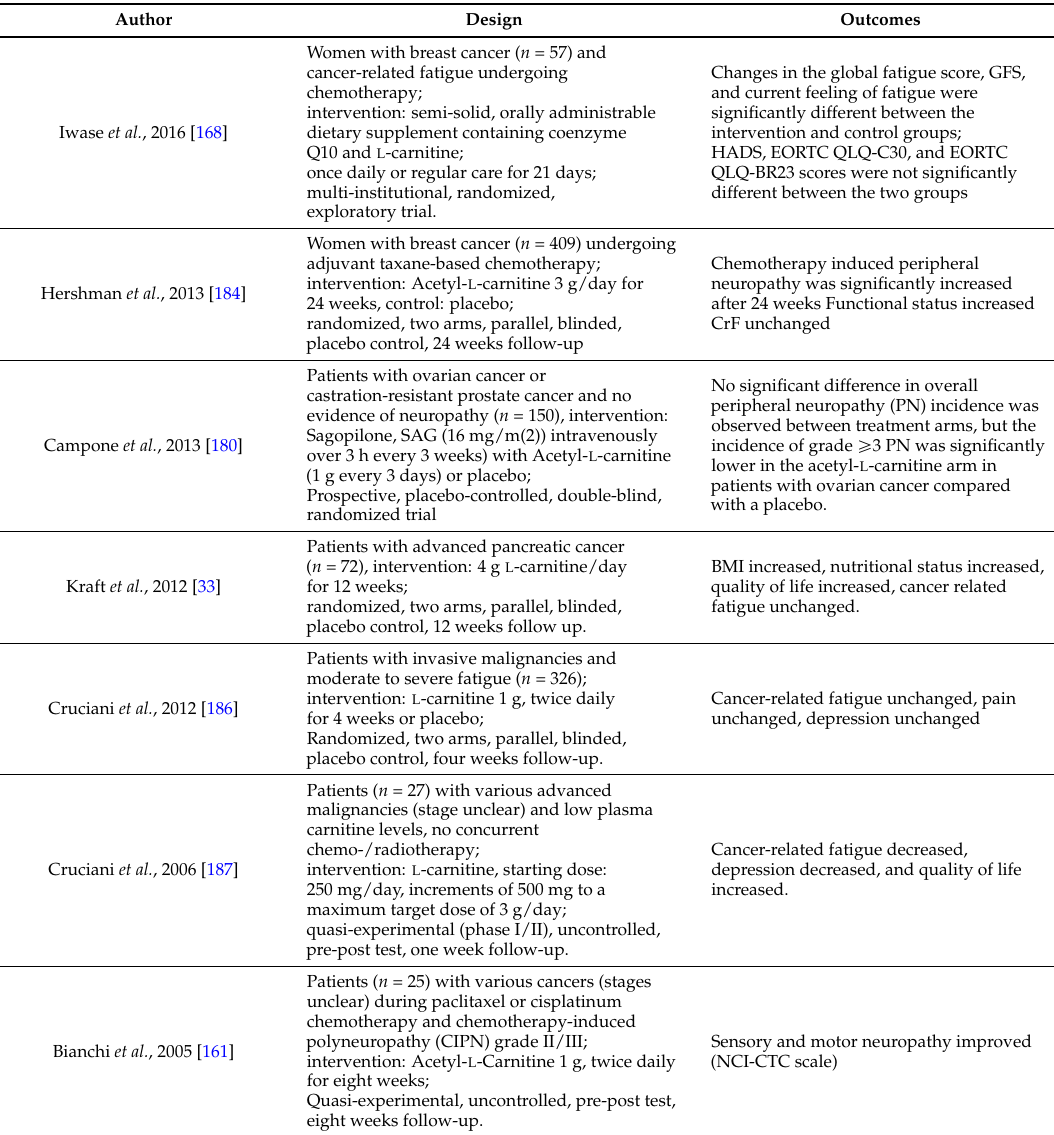
Table 4. Studies on the use of L -carnitine and acetyl- L -carnitine in